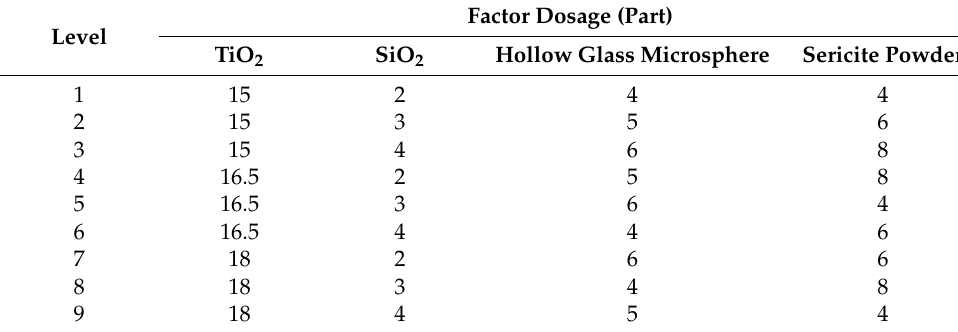
Table 5. Packing orthogonal design Table L9 (3 4 ).